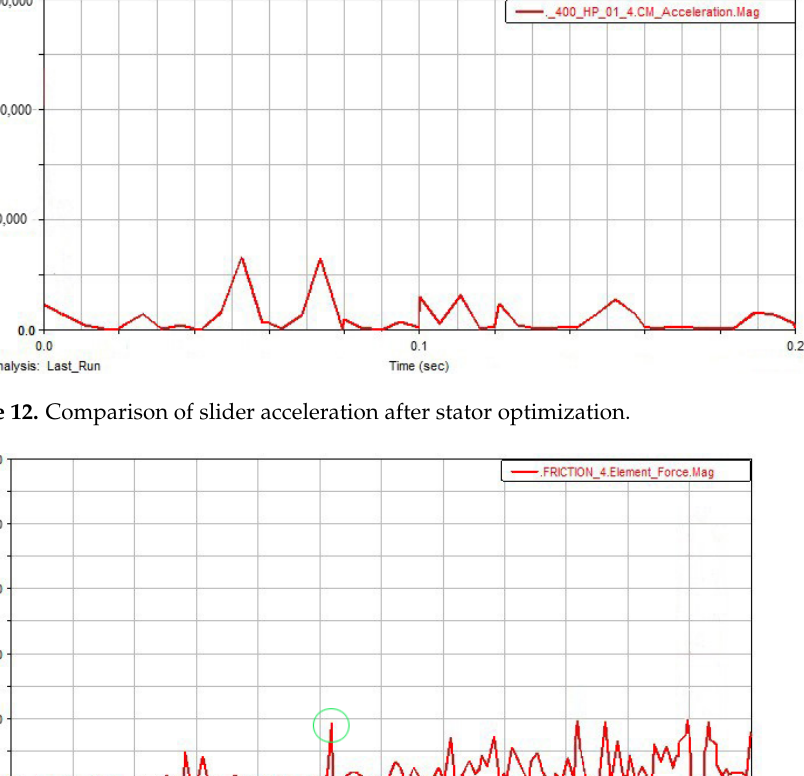
Figure 14. Comparison of friction between slider and rotor slider slot after stator optimization. (4) Slider–stator contact force curve before and after optimizing the stator cavity length to short radius ratio. As shown in Figures 15 and 16, the simulation results before stator cavity optimization show that the contact force between the slide and the stator has a sudden and extreme peak because when the difference of R − r is significant, a curve section with large curvature will be generated at the transition curve. As a result, when the slide slides on the stator transition curved surface, it will produce an excellent acceleration impact on this curved surface. Then, the slide and the stator will have a great elastic deformation, resulting in a sudden change in the contact force and causing a severe wear phenomenon. The simulation results of the stator cavity optimization show that the maximum value of the contact force between the slider and the stator is controlled within 21 N. Compared with the peak value of the contact force between the slider and the stator before optimization, which reaches 75 N, the peak value of the contact force between the slider and the stator is significantly reduced during the whole rotation cycle, which indicates that the optimization of the length and radius of the stator cavity has a beneficial effect on reducing the contact force between the slider and the stator.